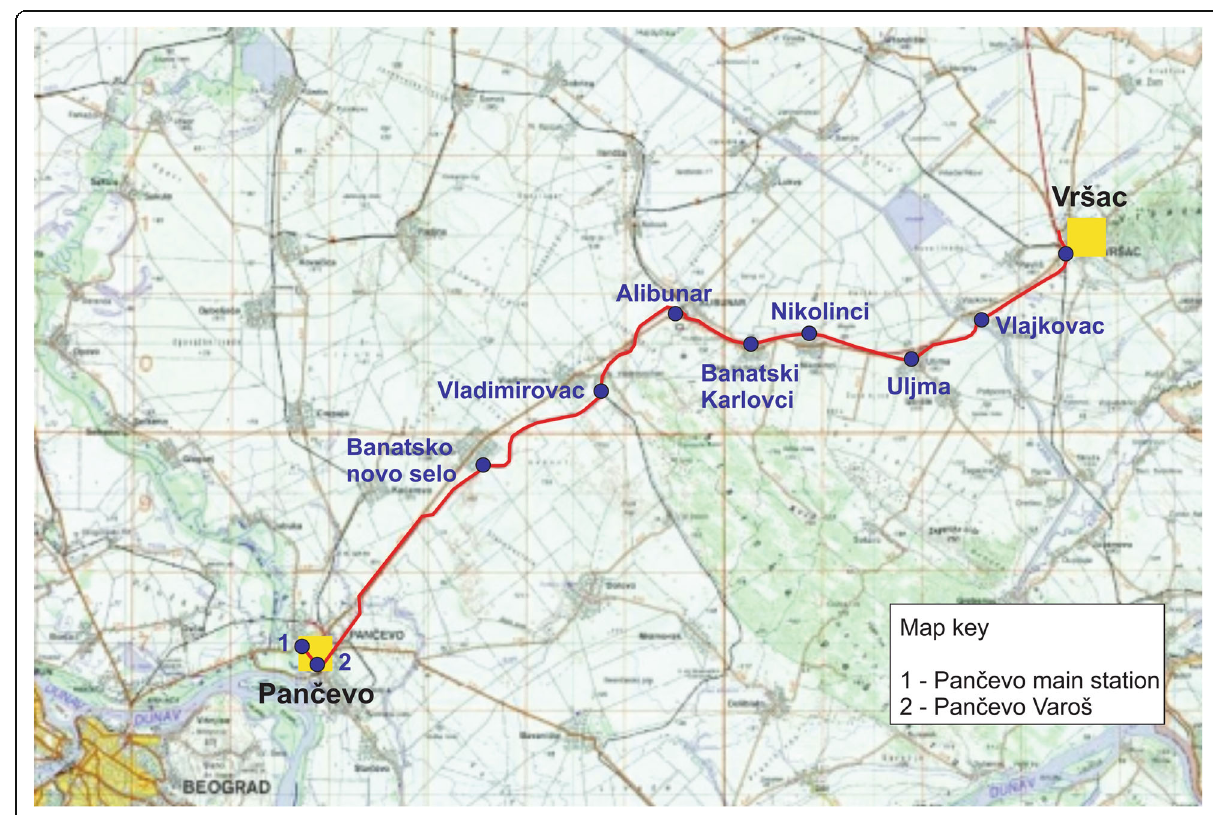
Fig. 5 Railway line Pan č evo - Vr š